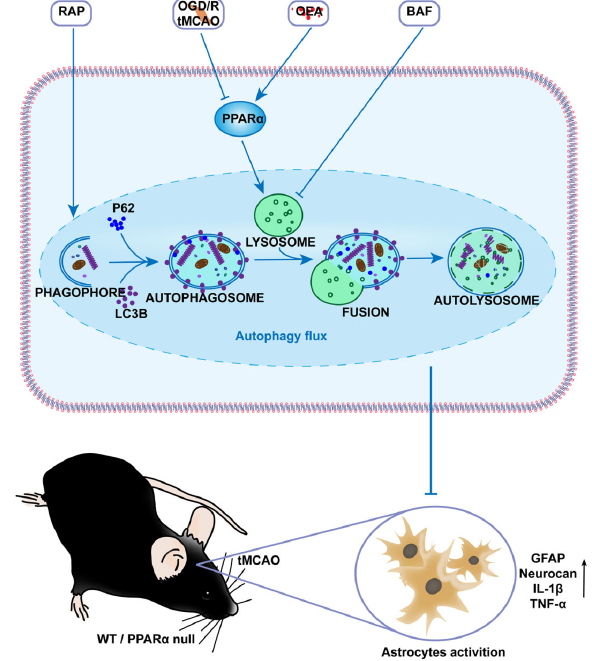
Figure 7. Schematic diagram illustrating the mechanism of the PPAR α -medicated inhibition of astrocyte inflammation activation after brain ischemia. PPAR α activation preserves the lysosome function and restores autophagic flux through the subsequent lysosomal degradation of autophagic vesicles after transient brain ischemia. Upwards arrow represents upregulation of the substances.